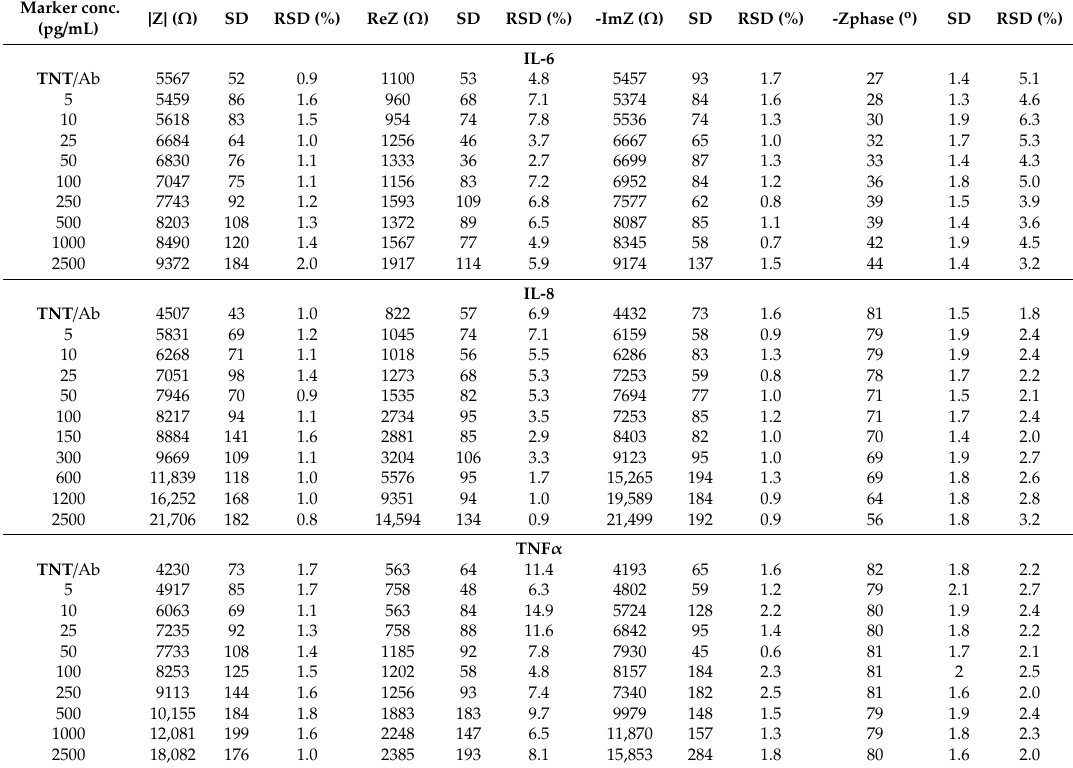
Table A1. Results of electrochemical impedance spectroscopy obtained for the varying concentration of IL-6, IL-8, TNF α immunoelectrode measured in 0.01 M PBS solution, where: SD – standard deviation, RSD—relative standard